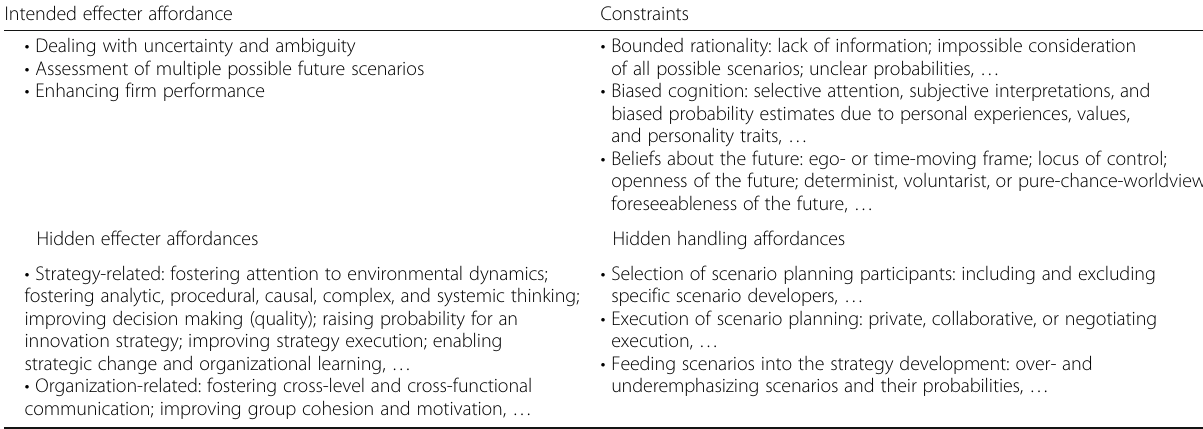
Table 1 Full range of affordances of scenario planning. Source: author Intended effecter affordance